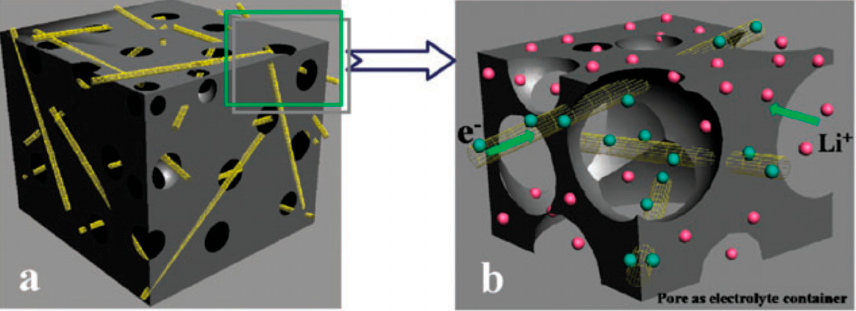
Figure 10. Schematic illustrations of the porous LiFePO 4 –CNT composite: ( a ) showing the corresponding electron transport and ion diffusion mechanisms; ( b ) is an enlarged zone from ( a ). Adapted with permission from [109], © Royal Society of Chemistry, 2010.